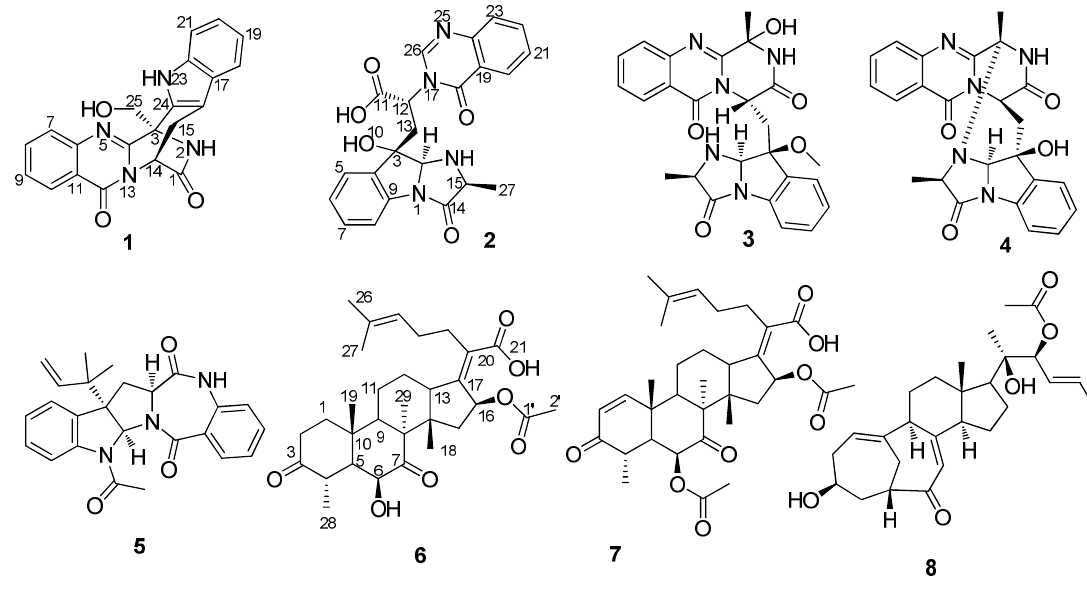
Figure 1. Structures of metabolites 1 – 8 .